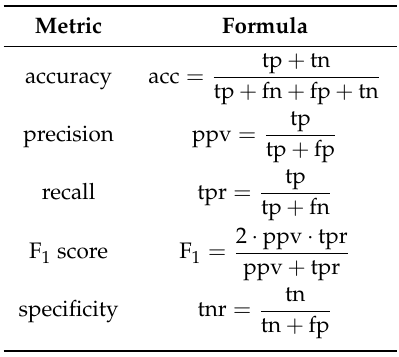
Table 2. Metrics for the evaluation of a binary classification problem.